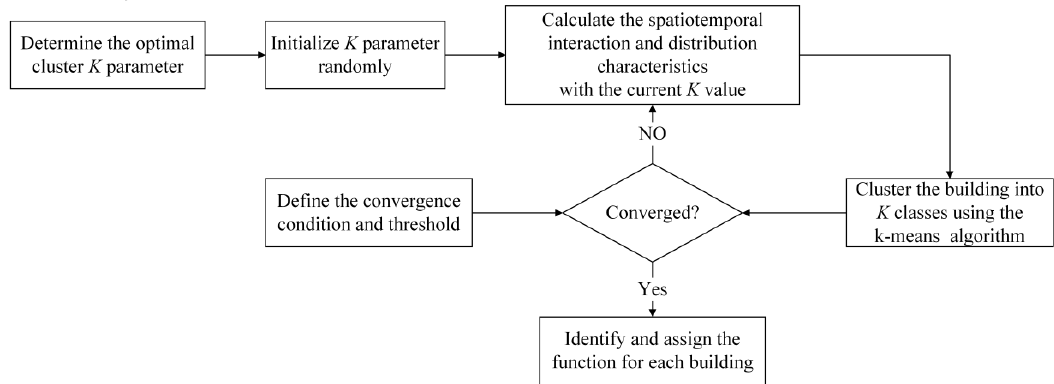
Figure 2. Flowchart of the proposed method for identifying the building functions.